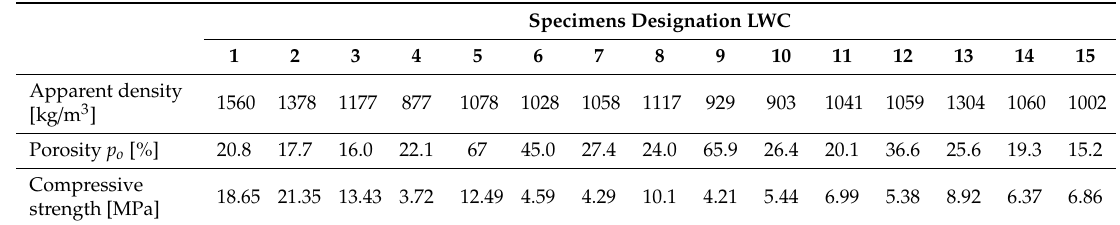
Table 5. Test results for lightweight concrete